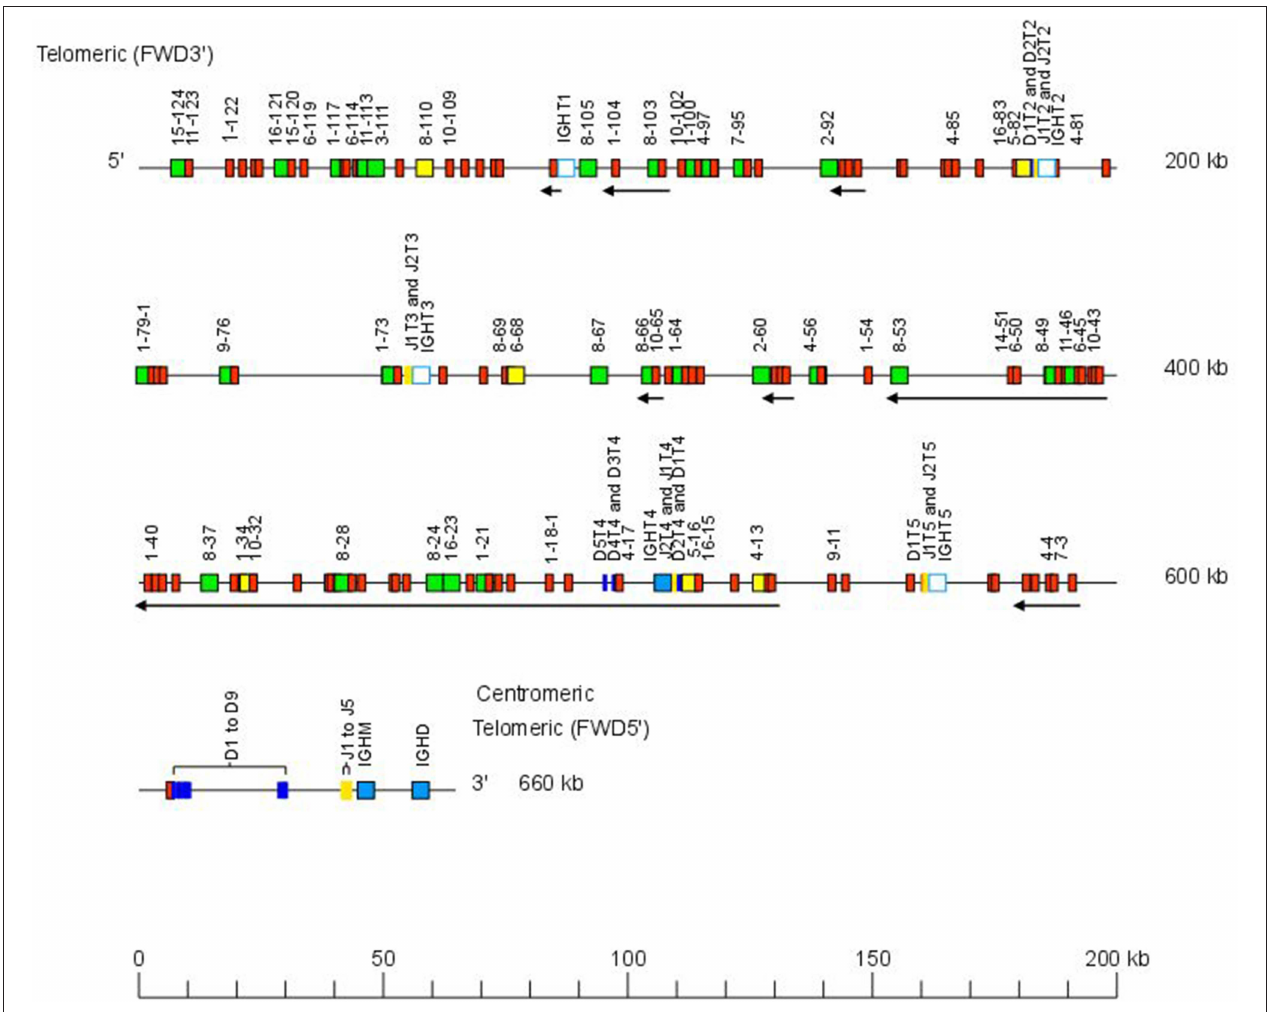
FIGURE 1 | Organization of the Atlantic salmon ( Salmo salar ) locus A. The orientation of the Atlantic salmon ( S. salar ) IGH locus on chromosome 6 (locus A—Salsal ssa06) is reverse (REV). IGH gene names are according to IMGT nomenclature ( 3). Single arrows show genes whose polarity is opposite to that of the D-J-C CLUSTER comprising IGHD (D1–D9)-IGHJ (J1–J5)-IGHM-IGHD. Gene names of IGHV pseudogenes with frameshift(s) in the V-REGION are not displayed due to lack of space in the locus map at the IMGT standardized scale (line = 200kb). All gene names are displayed in a zoom (line = 100kb) on the IMGT site [IMGT Repertoire (IG and TR) > Locus and genes > Locus representations] 1 . Color coding of genes is according to the IMGT Color menu for genes (IMGT Scientific chart > 4. Representation Rules > IMGT color menu > 11. Color menu for genes) 1 : V-GENE (green: functional, yellow: ORF, red: pseudogene), D-GENE (blue: functional), J-GENE (yellow: functional), and C-GENE (blue: functional, white box: pseudogene). With permission of IMGT ® , the international ImMunoGenetics information system ®